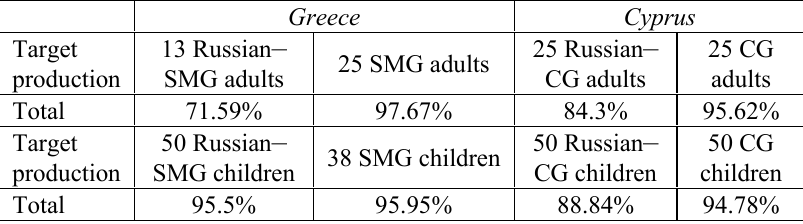
Table 6: Target test production: adults vs.